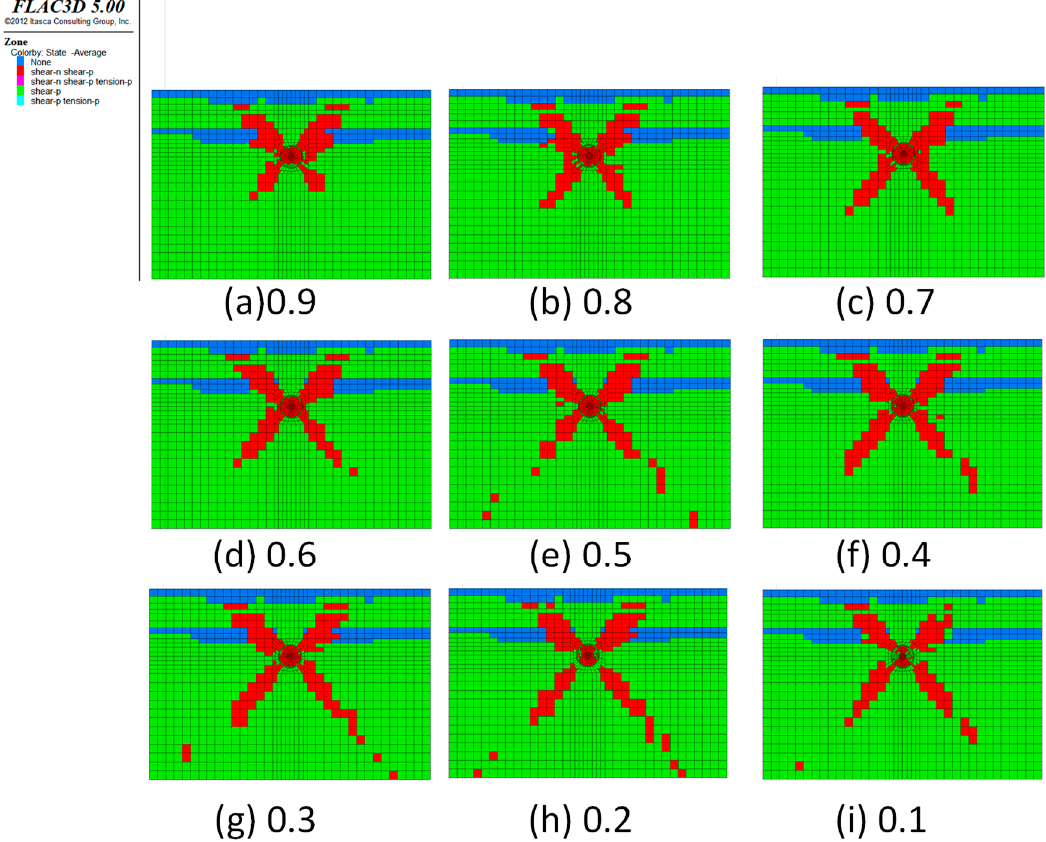
Figure 14. Distribution of plastic area in excavation face with different support force coefficients in Section 3. (The numerical value in the figure represents the support pressure coefficient).